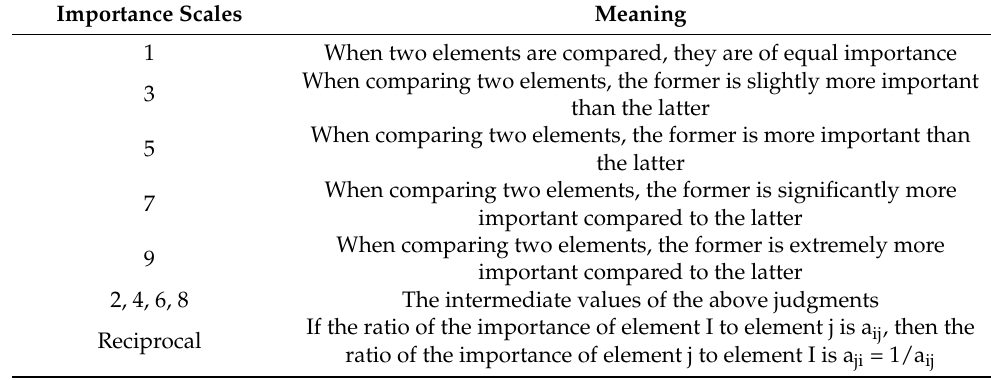
Table 4. Importance scales.